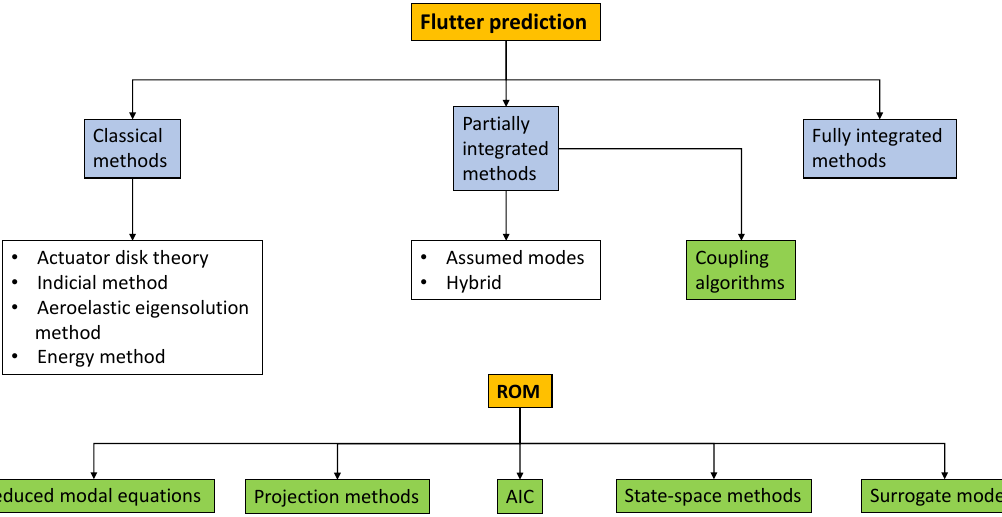
Figure 1. Structure of the paper. The schematic of different flutter simulation techniques is an extension of